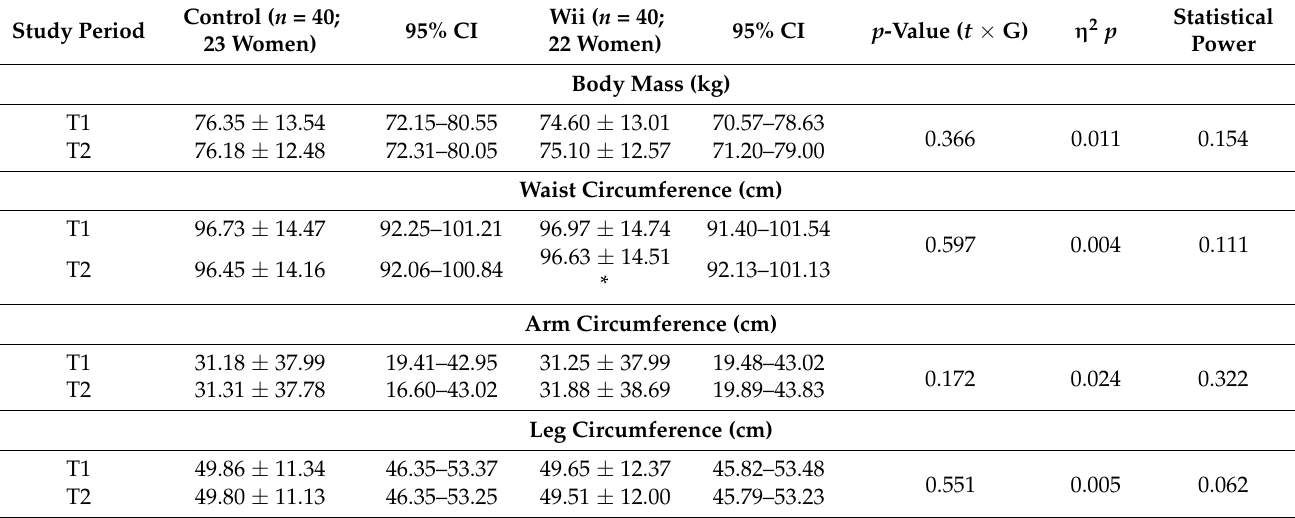
Table 1. Statistical analysis of the anthropometric parameters.